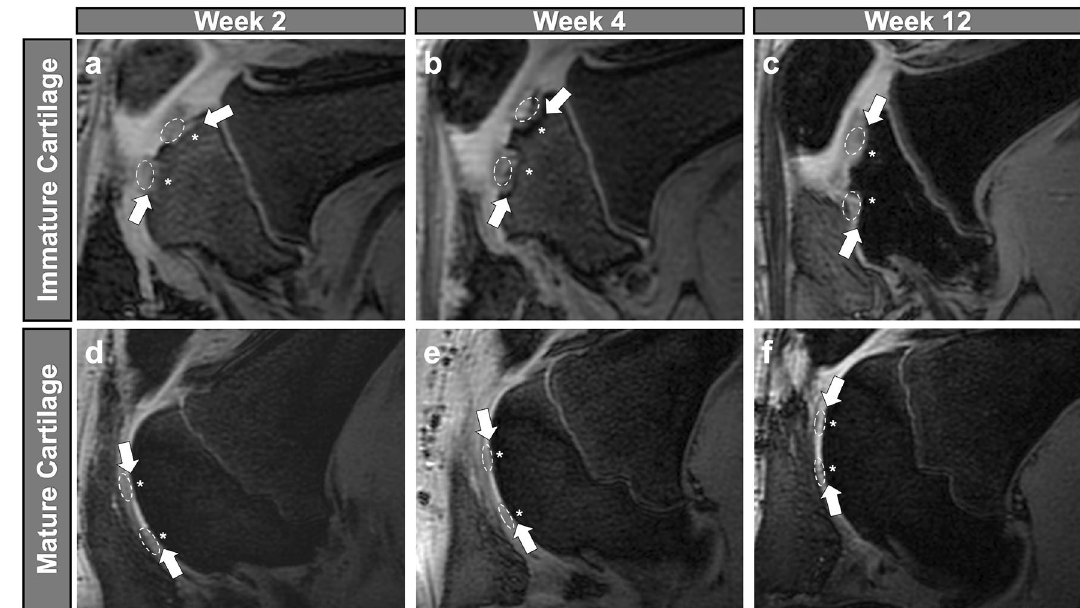
Figure 1. Sagittal SPGR 3D FS knee MRI of the immature and mature pigs after MASI. In the immature knee joint (a–c) , at 2 weeks after MASI (a) , MRI demonstrates MSC implants (dashed lines) in full-thickness cartilage defects (arrows). On follow-up imaging scans at week 4 (b) , the knee joint demonstrates associated subchondral edema (asterisks) and bone defect in the subchondral bone (arrows). The follow-up imaging study of the immature joint at 12 weeks after MASI (c) demonstrates a persistent size of the cartilage defect and increasing size of the subchondral bone defect (arrows). In the mature knee joint (d–f) , at 2 weeks after MASI (d) , MSC implants (dashed lines) in full-thickness cartilage defects and intact subchondral endplate (arrows) are appreciated. In contrast to the immature joint, on follow up MR imaging of the mature joint, the knee joint demonstrates limited subchondral edema (asterisks) and the size of the cartilage defects and subchondral bone defects (arrows) decreases at week 4 (e) , and week 12 (f) after MASI, consistent with progressive